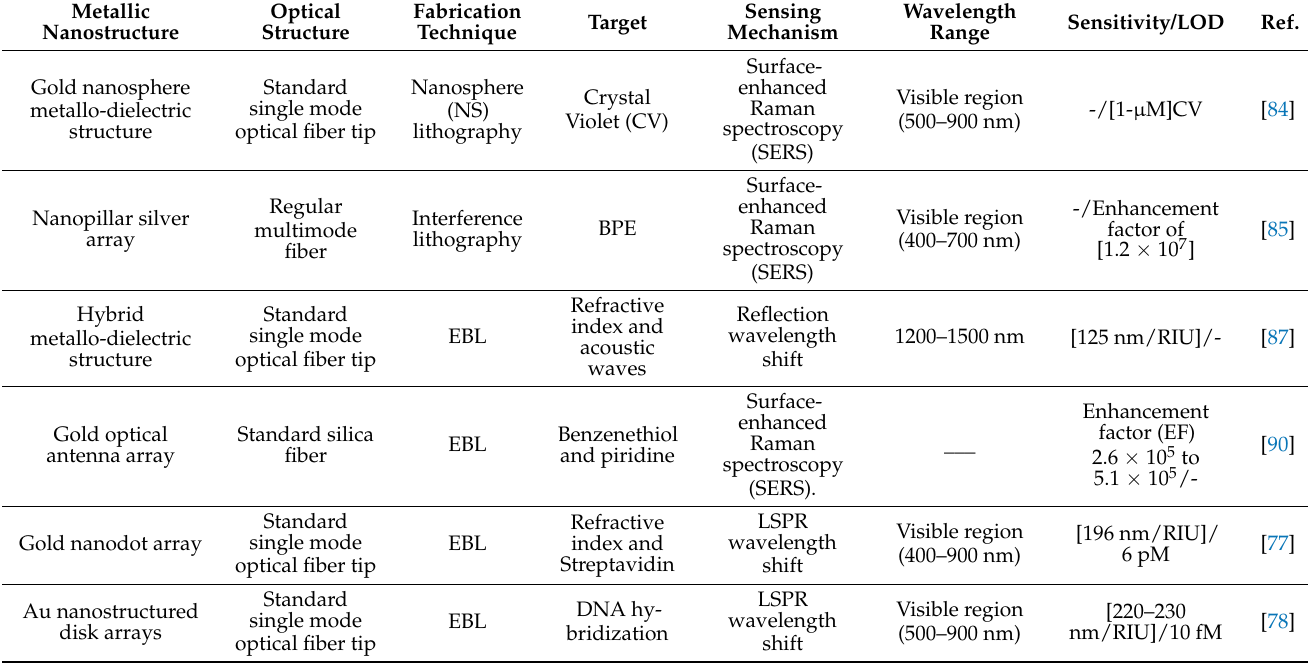
Table 3. Summary of the different ordered structures on optical fiber tip composed of plasmonic materials with their corresponding optical structure, target of study, sensing mechanism, wavelength range and